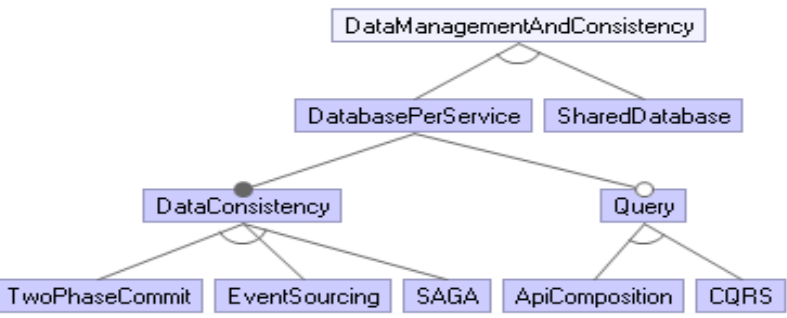
Figure 4. Feature diagram of data management and consistency.